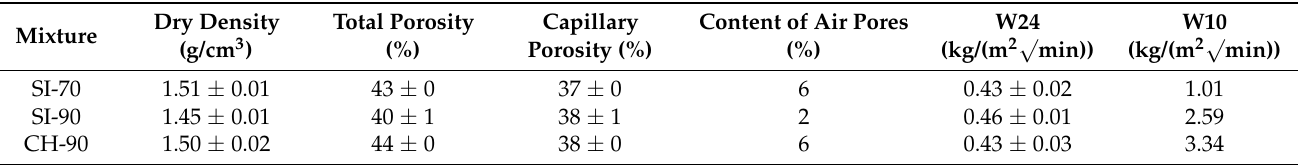
Table 7. Density of hardened state (g/cm 3 ); total and capillary porosity (%); and water absorption coefficient after 24 h (W 24 ) and 10 min (W 10 ) of the SI and CH mixtures.